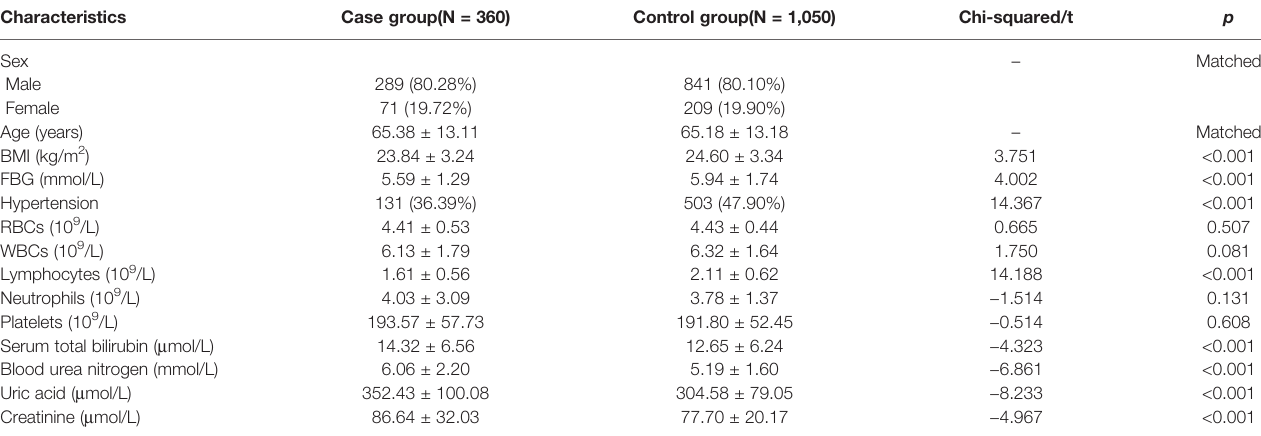
BMI, body mass index; FBG, fasting blood glucose; RBCs, red blood cells; WBCs, white blood cells.